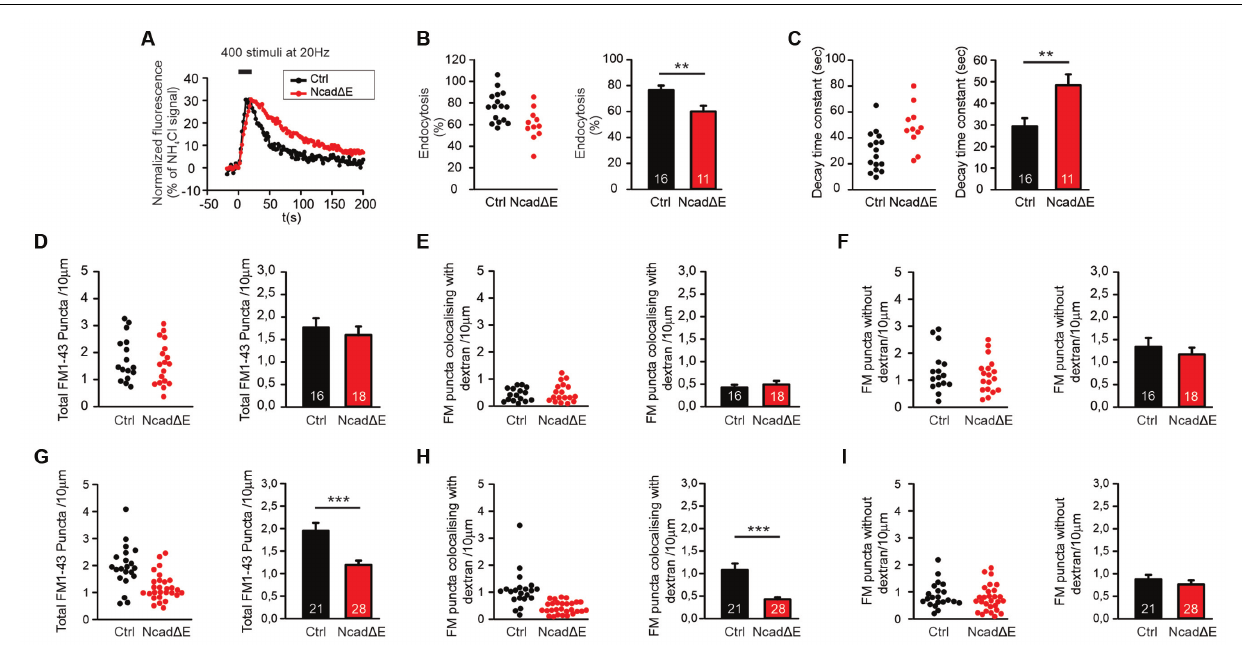
FIGURE 4 | Inhibition of N-cadherin function by Ncad ∆ E expression resulted in reduced synaptic vesicle endocytosis. (A–C) Inhibiting the function of N-cadherin by co-expressing a dominant-negative N-cadherin fragment (Ncad ∆ E) lacking the extracellular domains (with DsRed2 and SypHy at 9 DIV in individual cortical neurons) resulted in a significant reduction in synaptic vesicle endocytosis at autapses at near physiological temperature (34 ◦ C). SypHy imaging was performed at 12–14 DIV with 400 stimuli at 20 Hz. n = 16 (control)/11 (Ncad ∆ E) cells, the total number of SypHy puncta analyzed were 463/192. (A) Example time courses of mean SypHy fluorescence intensities (all puncta per cell averaged, normalized to NH 4 Cl signal) for control (co-expressing DsRed2 + SypHy; black) and Ncad ∆ E expressing (co-expressing DsRed2 + SypHy + Ncad ∆ E; red) neurons at 34 ◦ C. (B) Quantitative analysis of endocytosis at 90 s after the end of stimulation (SypHy signal loss as % of maximal SypHy signal) in individual neurons ( left ), and means ± SEM for control and N-cad ∆ E expressing neurons ( right ). P = 0.007. (C) Quantification of SypHy signal decay time constant (tau, monoexponential fit) in individual neurons ( left ), and means ± SEM for control and N-cad ∆ E expressing neurons ( right ). P = 0.005. (D–F) Postsynaptic functional block of N-cadherin by sparse Ncad ∆ E expression in mass cultures of cortical neurons did not result in a significant change in vesicle endocytosis at 25 ◦ C, as studied by uptake of FM1–43 and TMR-dextran induced by 200 stimuli at 20 Hz. (D) Quantification of the dendritic density of total FM1–43 puncta in individual transfected neurons ( left ), and means ± SEM (black: control; red: N-cad ∆ E expression; n = 16/18 cells, right ). (E) Quantification of the dendritic density of FM1–43 puncta co-localizing with TMR-dextran in individual neurons ( left ), and means ± SEM ( right ). TMR-dextran uptake is very low at this experimental condition (baseline uptake). (F) Quantification of the dendritic density of FM1–43 puncta not co-localizing with TMR-dextran in individual neurons ( left ), and means ± SEM ( right ). (G–I) Postsynaptic inhibition of N-cadherin function by Ncad ∆ E expression resulted in significant impairment in bulk endocytosis at 34 ◦ C (400 stimuli at 20 Hz). (G) Quantification of the dendritic density of total FM1–43 puncta in individual transfected neurons ( left ), and means ± SEM (black: control; red: Ncad ∆ E expression; n = 21/28 cells, right ). P < 0.001. (H) Quantification of the dendritic density of FM1–43 puncta co-localizing with TMR-dextran in individual neurons ( left ), and means ± SEM ( right ). P < 0.001. (I) Quantification of the dendritic density of FM1–43 puncta not co-localizing with TMR-dextran in individual neurons ( left ), and means ± SEM ( right ). ** P < 0.01, *** P < 0.001, Student’s t -test ( B,C) . Whenever the normality test failed Mann-Whitney’s test on ranks was performed (D–I)